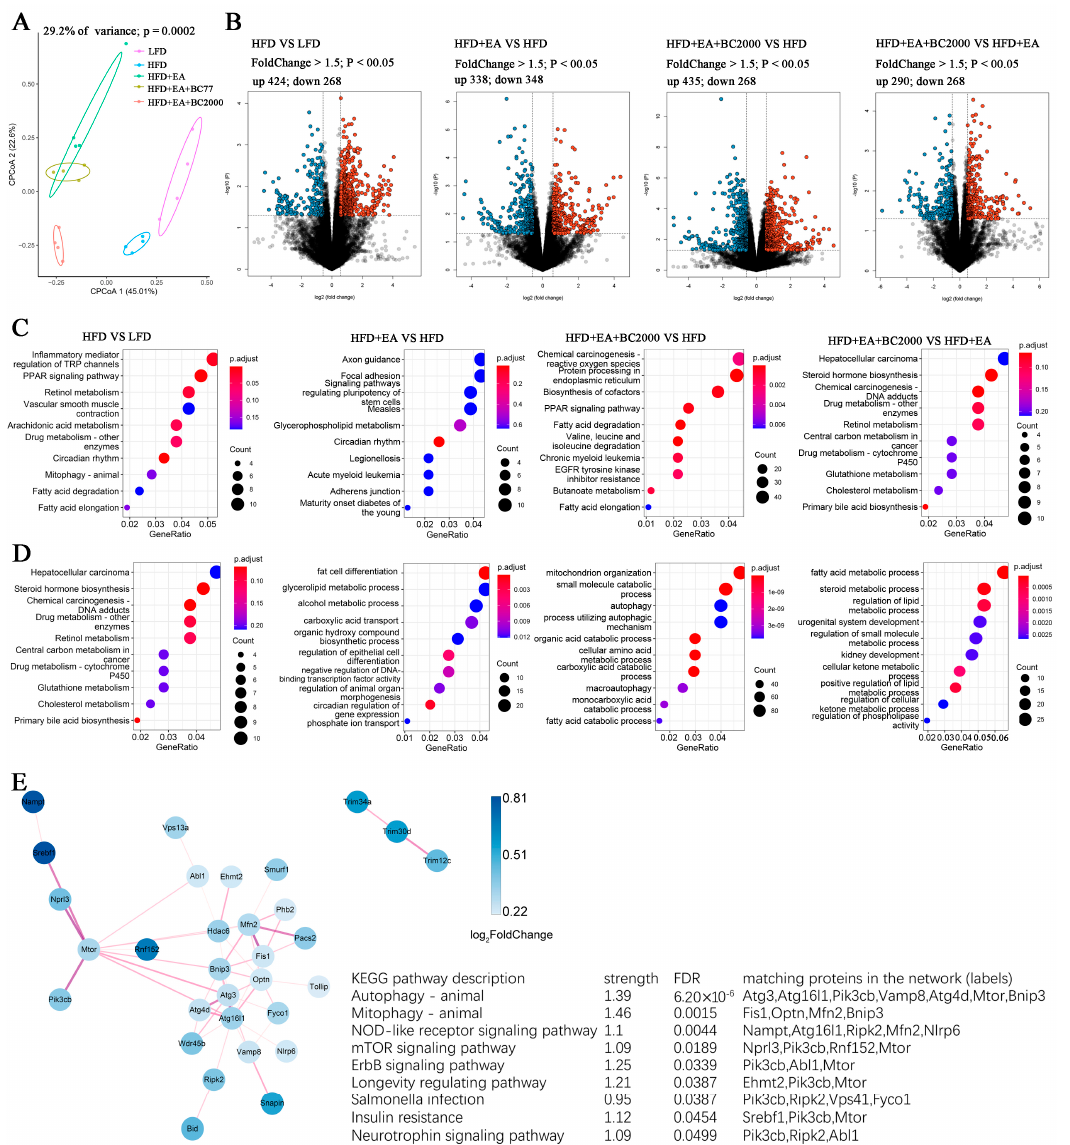
Figure 6. Impact of BC2000 on gene expression in mouse liver; ( A ) CPCoA; ( B ) volcano plot; ( C ) GO enrichment analysis of biological processes; ( D ) GO enrichment analysis of molecular functions; ( E ) interaction network map of the KEGG pathway based on differentially expressed genes. n = 4/group. LFD: low-fat-diet group; HFD: high-fat-diet group; HFD + EA: high-fat-diet supplemented with ellagic acid; HFD + EA + BC77: high-fat-diet supplemented with ellagic acid and W. coagulans BC77; HFD + EA + BC2000: high-fat-diet supplemented with ellagic acid and W. coagulans